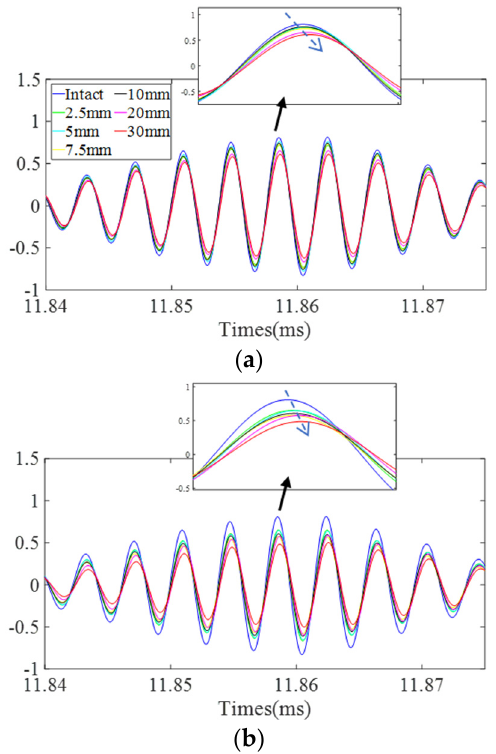
Figure 15. Variation of ultrasonic wave: ( a ) site 1; ( b ) site 2.